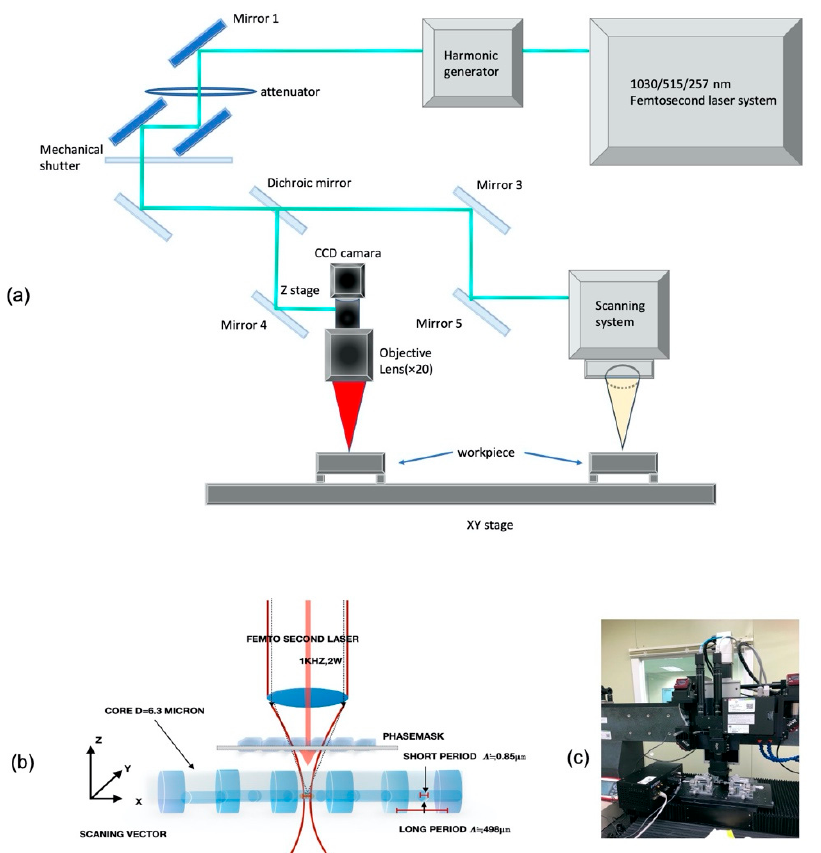
Figure 2. ( a ) schematic diagram of a femtosecond laser micro machining system; ( b ) femtosecond laser phase mask grating process structure diagram; and ( c ) real femtosecond laser precision machining stage.